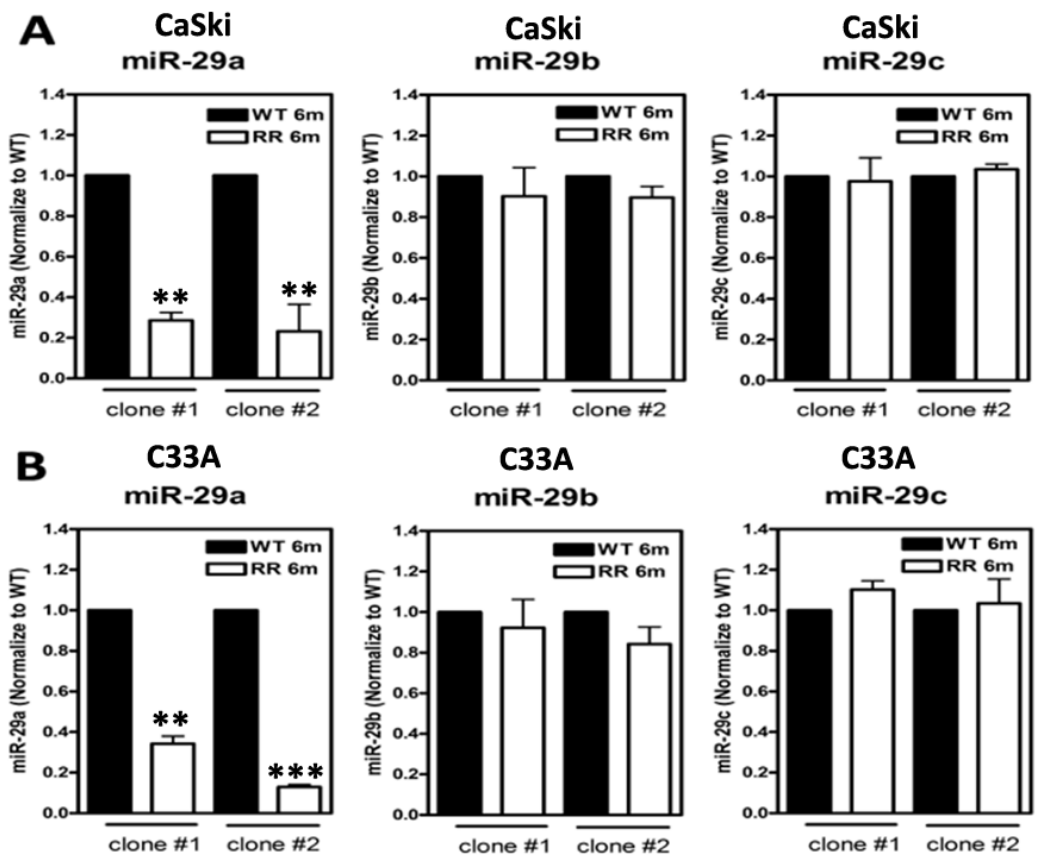
Figure 1. Suppressed miR-29a but not miR-29b/c in radioresistant (RR: 6 months) clones and their parental wild-type (WT) clones generated from CaSki and C33A cervical cancer cells. ( A ) Expression levels of miR-29a/b/c in WT and RR cervical cancer cells (CaSki) and ( B ) C33A cells. Cells were cultivated, collected, and the total microRNA was extracted, and expression levels of miR-29a , miR-29b, or miR-29c were estimated by quantitative RT-PCR analysis. The results were from two independent clones of CaSki and C33A cells, and each clone was repeated at least three times, and the results were similar. Data were shown as mean ± SD. ** p < 0.01, *** p < 0.001 for RR group vs. WT group.